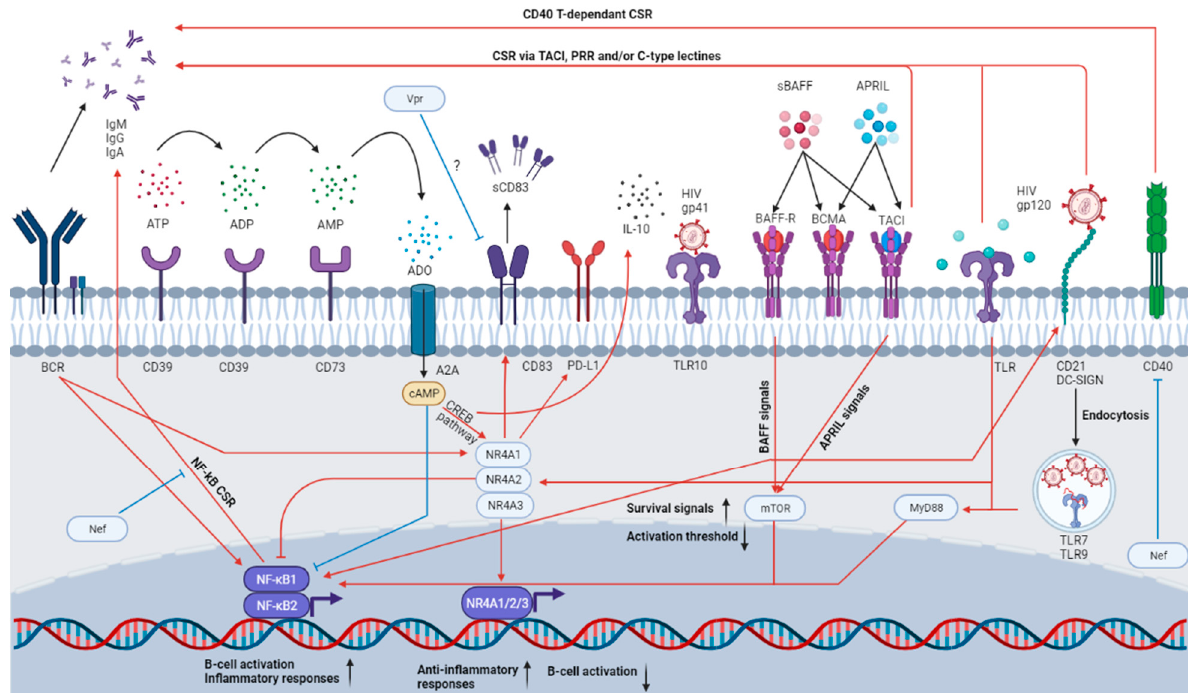
Figure 2. MZp immune functions and how they can be affected in the HIV context. MZps possess a strong Breg potential, as attested by the expression of several immunoregulatory molecules. Indeed, MZps express CD39 and CD73, which will convert the extracellular ATP into ADO. This molecule will then be uptaken by purinergic receptors such as A2 A , which will induce cAMP accumulation in the cytosol and the activation of the CREB pathway. CREB will induce the expression of CREB-induced elements such as the NR4A molecules and IL-10, which will allow for the maintenance of a regulatory phenotype. The NR4As will then induce the expression of even more immunoregulatory molecules such as CD83 and PD-L1, while also impeding unwanted cell activation by the BCR or the TLR. However, this homeostasis is heavily altered in the HIV context due to the chronic inflammation, excess BAFF and viral proteins. For instance, MZ B-cells are able to class-switch following CD40 engagement and subsequent NF-kB pathway activation. However, in the HIV context, HIV Nef could impede this CSR. HIV gp120 could activate B-cells by cross-linking DC-SIGN an action that is enhanced by BAFF. Excess BAFF could induce TACI-dependent CSR by activating the mTOR pathway, which intersects with the TLR pathway (also engaged due to HIV-mediated recognition by TLR7, expressed by MZ B-cells), lowering the MZ activation threshold. HIV proteins such as Vpr could also directly affect MZp immunoregulatory protein expression such as CD83. Thus, in the HIV context, MZps could possibly lose their immunoregulatory functions, become easily activated and produce poor-affinity antibodies, with possible